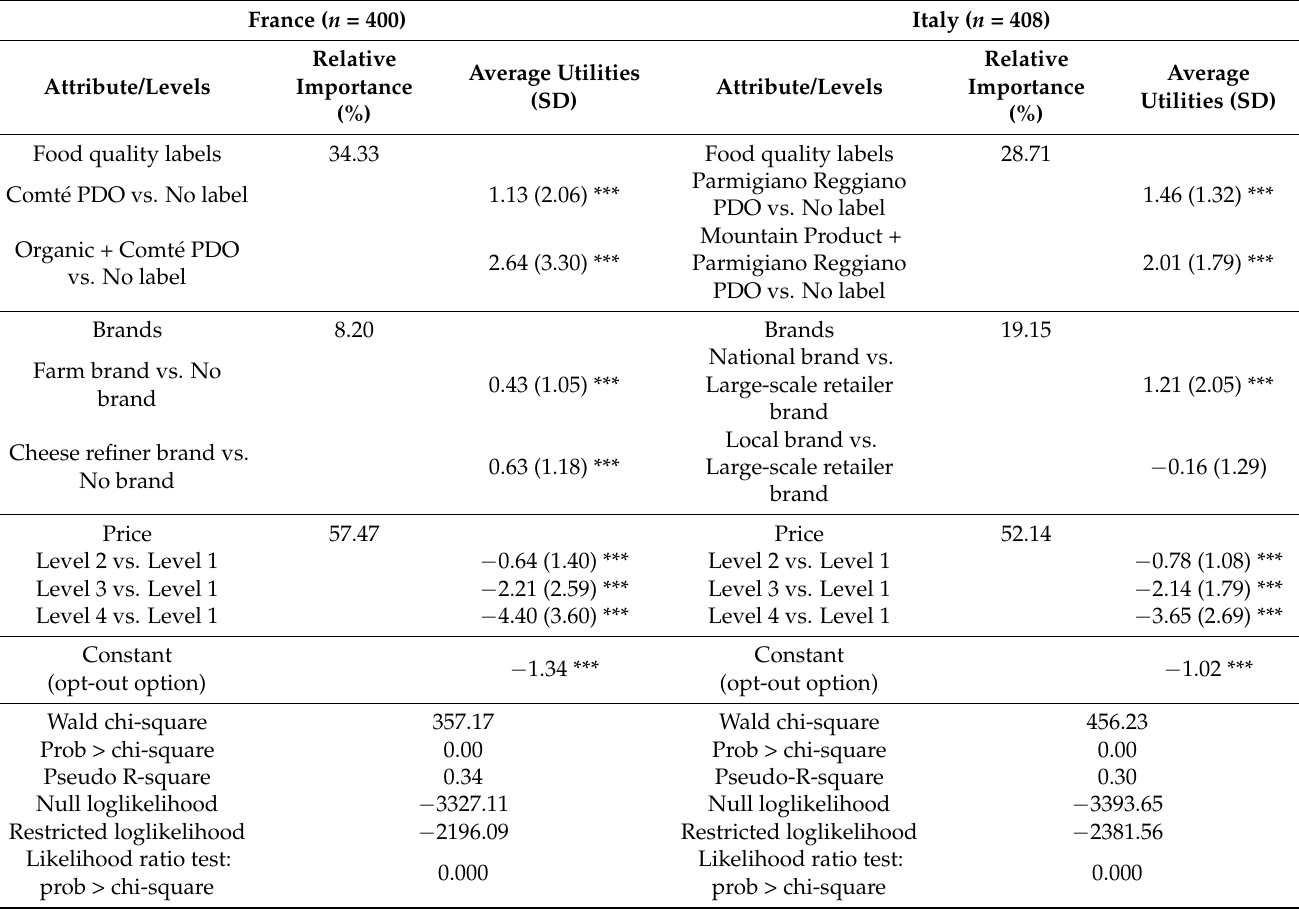
Table 3. Random-parameter logit model for DCE